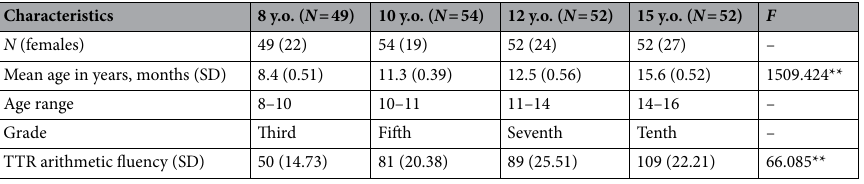
Table 3. Participants’ characteristics. ** p <